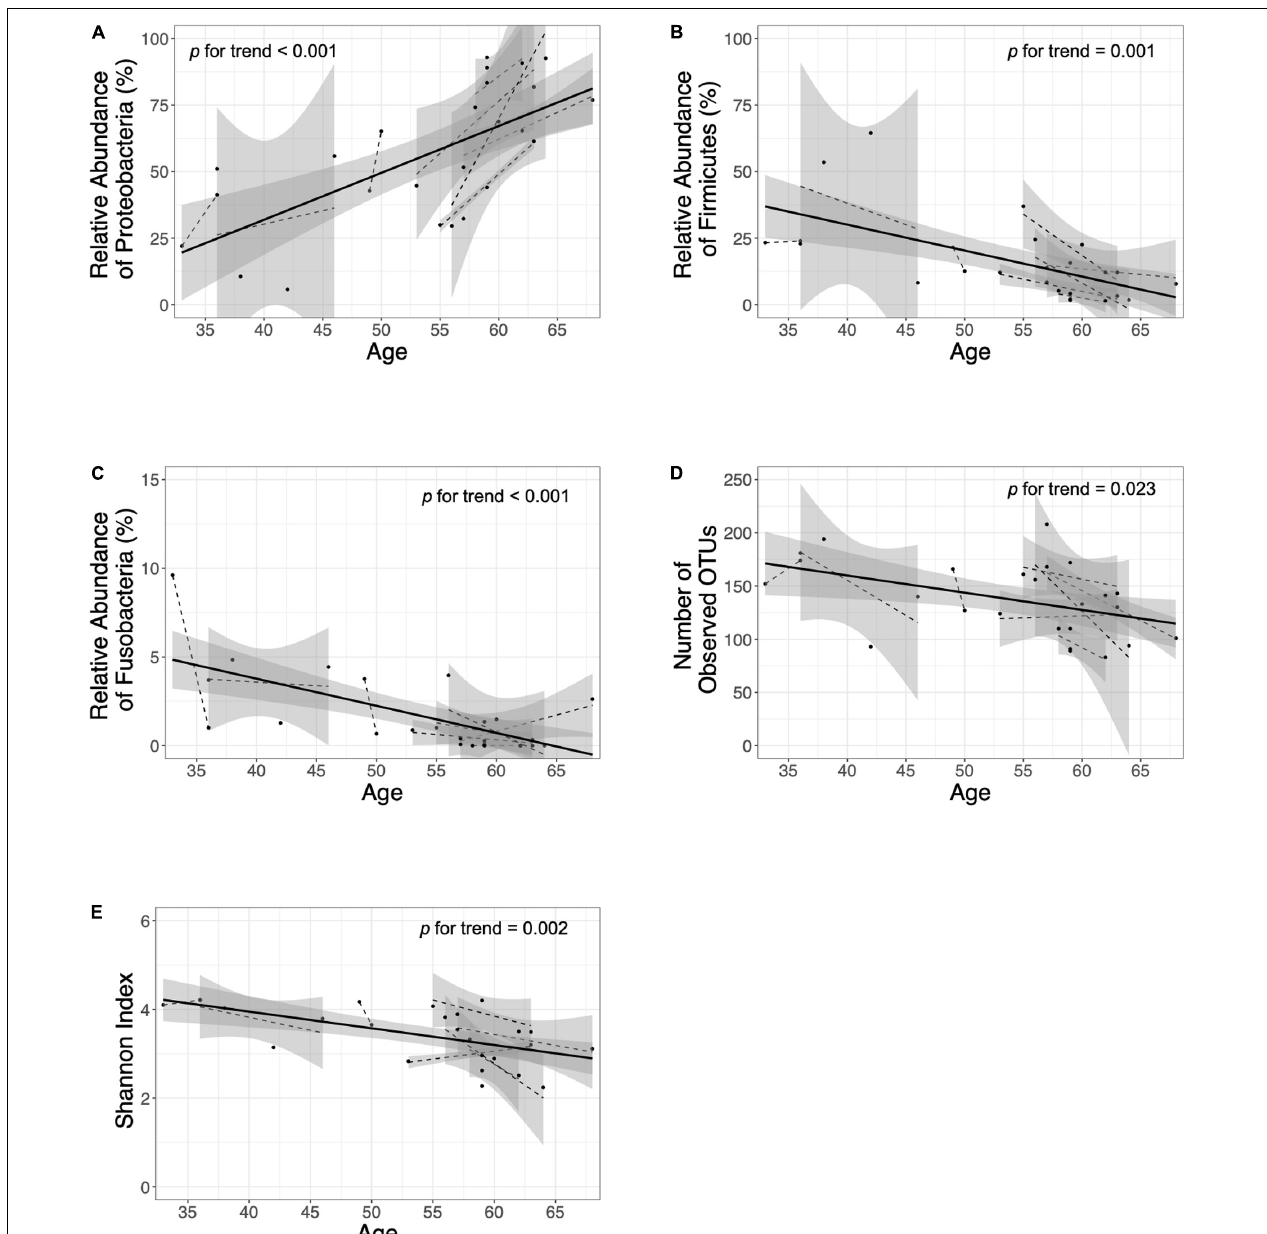
FIGURE 3 | Follow-up of the H. pylori -negative/non-atrophy subjects ( n = 8). At phylum level, an increase in (A) Proteobacteria abundance and a decrease in (B) Firmicutes and (C) Fusobacteria abundance were observed during the follow-up. In addition, a decrease in α -diversity indices (number of observed OTUs and Shannon index are presented in panel D and E , respectively) were observed. OTUs, operational taxonomy